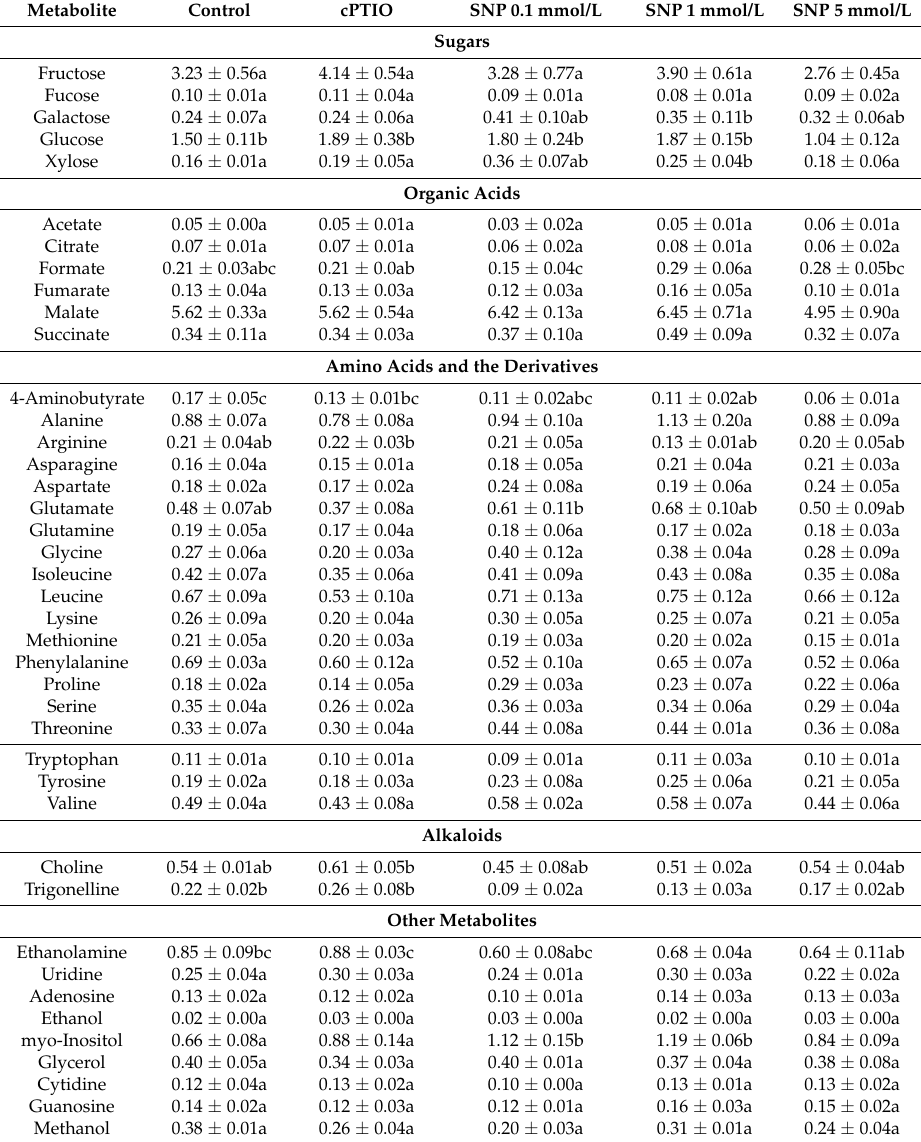
Table A1. Metabolites alterations caused by different NO treatments analyzed by NMR.